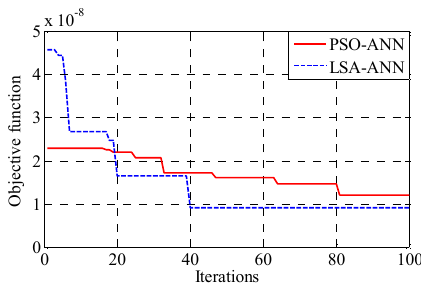
Figure 24. Performance comparison of LSA and PSO.